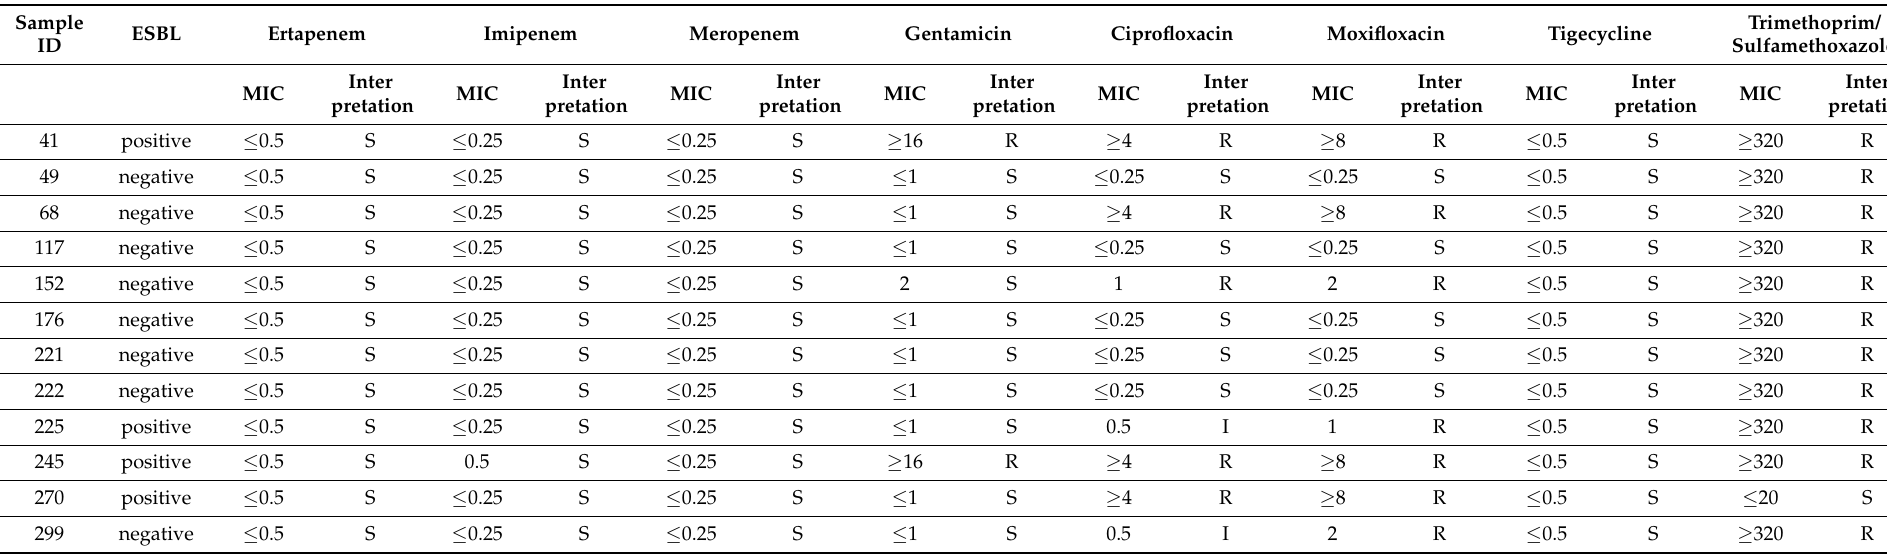
Table A8. Phenotypic resistance of Escherichia coli strains. MIC = minimum inhibitory concentration. ESBL = signal in phenotypic testing for extended-spectrum